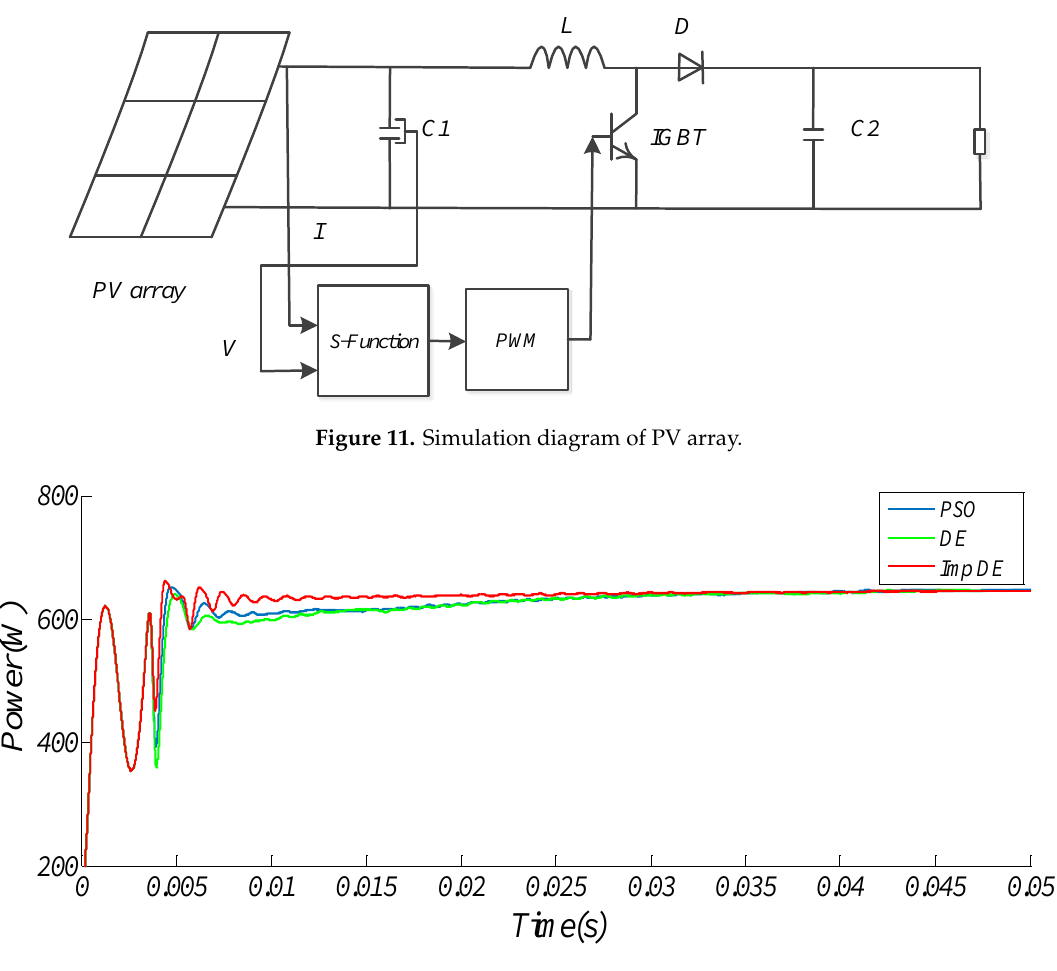
Figure 12. Simulation diagram of particle swarm optimization (PSO), DE algorithm and improved DE algorithm in case 1. Energies 2020 , 13 , 1254